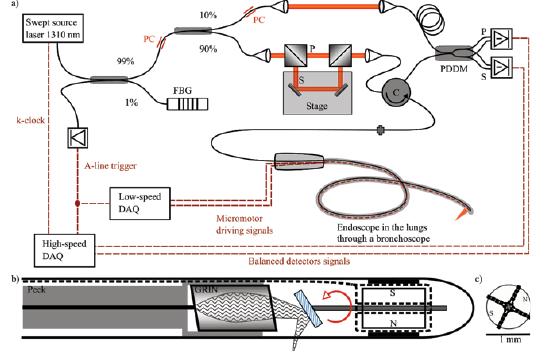
Fig. 1. a) Schematic of the PS-OCT system. b) Schematic of the OCT